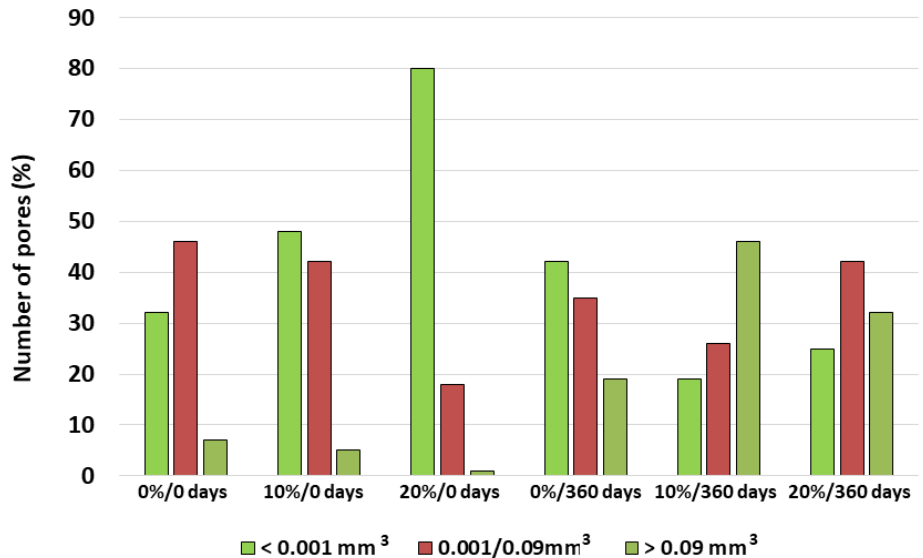
Figure 5. Macroporosity quantification (in % of number of pores) grouped into three pore volume range (>0.09 mm 3 , 0.09 mm 3 –0.001 mm 3 , <0.001 mm 3 ) for PR-1 sample.